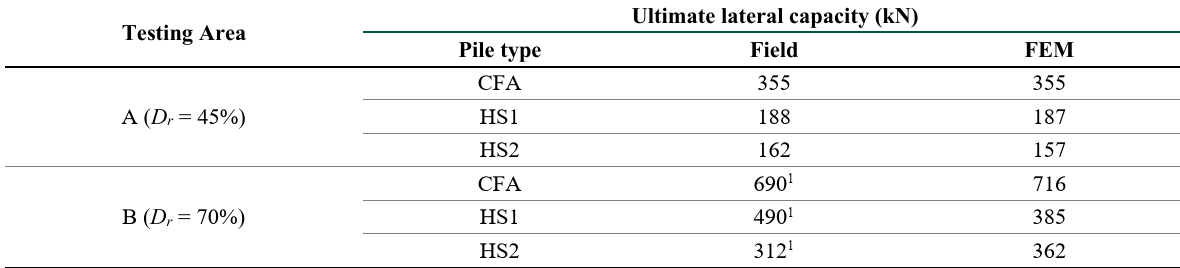
Table 3. Comparison of lateral load capacity of CFA and steel H-section piles obtained from the field tests and the numerical